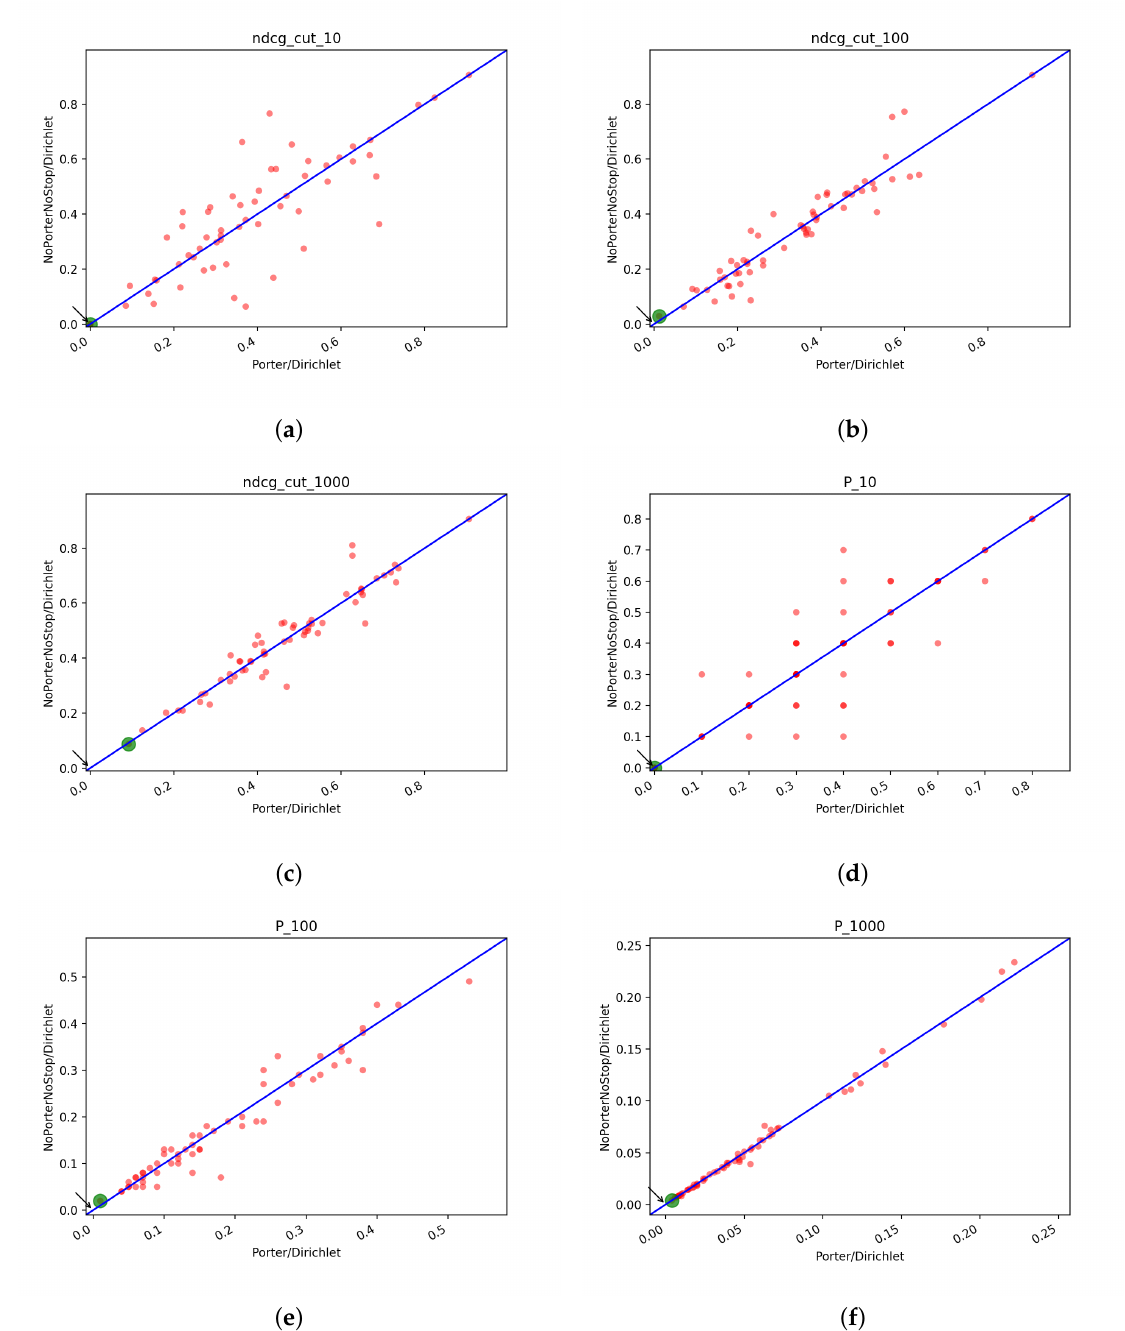
Figure 15. T1: scatter plots for Porter/Dirichlet vs. NoPorterNoStop/Dirichlet with QE+RF: ( a )